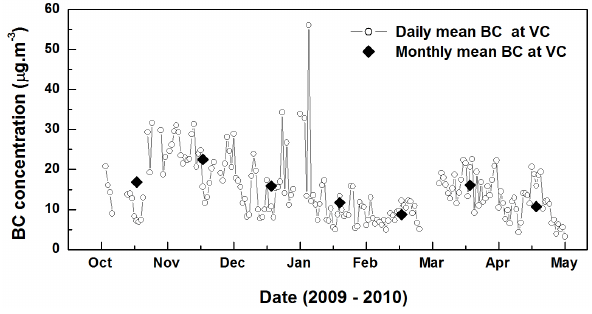
Fig. 5. Daily and monthly mean variation of BC concentrations at SVI 1 village centre (VC).